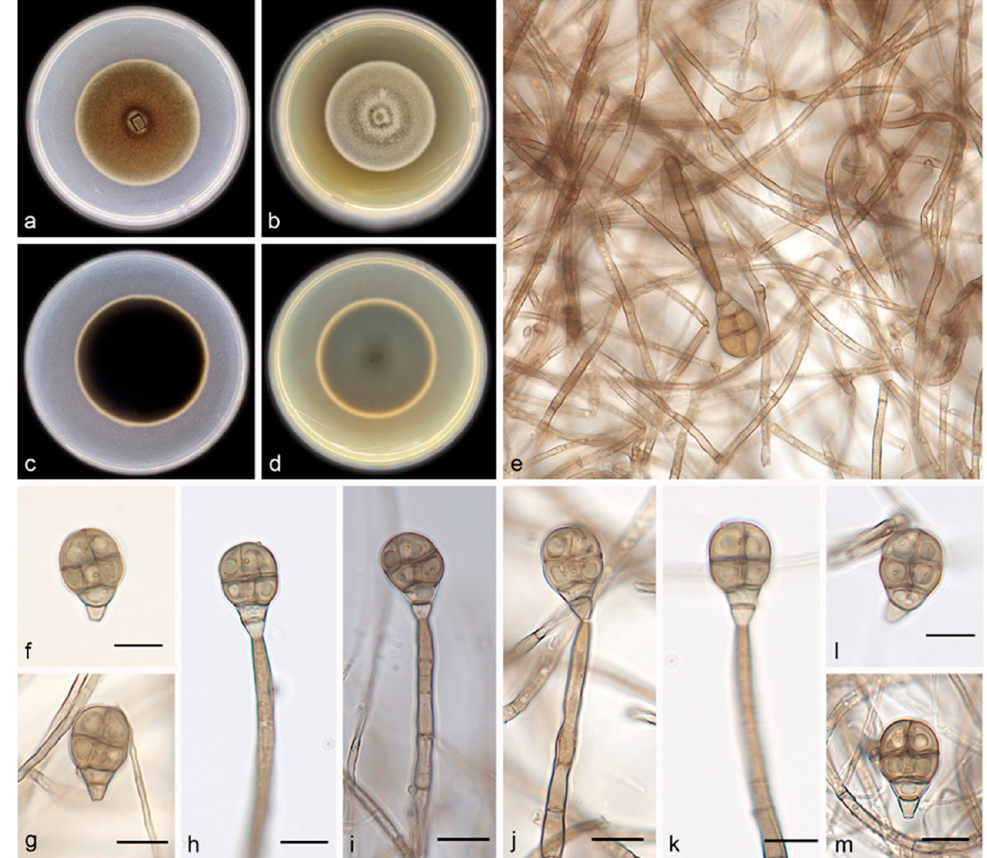
Figure 4. Acrodictys ellisii (holotype HMAS 352237, ex ‐ holotype SAUCC 1471): ( a , b ) surface sides of colony after incubation for 30 days on PDA ( a ) and MEA ( b ); ( c , d ) reverse sides of colony after incubation for 30 days on PDA ( c ) and MEA ( d ); ( e – m ) conidiophores, conidiogenous cells. and conidia. Petri dish diameter: 90 mm ( a – d ). Scale bars: 10 μ m ( e – m ). Description ― Asexual morph on PDA: Conidiophores are macronematous, mo ‐ nonematous, erect, unbranched, straight or flexuous, thick ‐ walled, smooth, pale brown, septate, and 47.0–82.0 × 2.1–5.2 μ m. Conidiogenous cells are monoblastic, integrated, ter ‐ minal, determinate, cylindrical, pale brown, and smooth. Conidia are solitary, muriform, obovoid to obpyriform, pale brown to brown, and 17.0–22.0 × 11.0–14.0 μ m, usually with 3 transverse septa and 1–3 longitudinal septa; they are slightly constricted at the septa and truncate at the base.